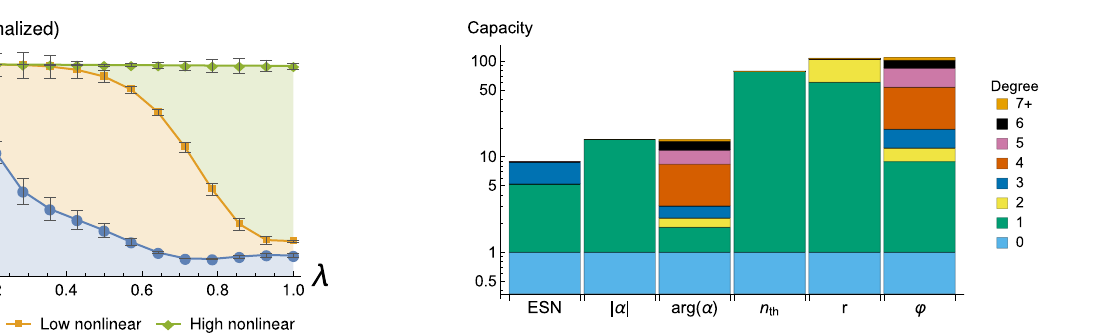
Fig. 3 Control of nonlinearity of reservoir memory via input encoding. Here the input s k ∈ [ − 1, 1] is encoded to the displacement of the ancilla according to ∣ α ∣ → (1 − λ )( s k + 1) + λ , arg ð α Þ ! 2 πλ s k , where λ ∈ [0, 1] is a parameter controlling how much we encode to the amplitude ∣ α ∣ or phase arg ð α Þ of the displacement. Reservoir memory is measured using information processing capacity, which quanti fi es the ability of the reservoir to reconstruct functions of the input at different delays. The fi gure shows how the relative contributions from linear and nonlinear functions to the normalized total capacity can be controlled with λ . Nonlinear contributions are further divided to degrees 2 and 3 (low nonlinear) and higher (high nonlinear). For λ = 0 the encoding is strictly to ∣ α ∣ , leading to linear information processing, while at λ = 1 only arg ð α Þ depends on the input, leading to most of the capacity to come from functions of the input with degree at least 4. All results are averages over 100 random reservoirs and error bars show the standard deviation.